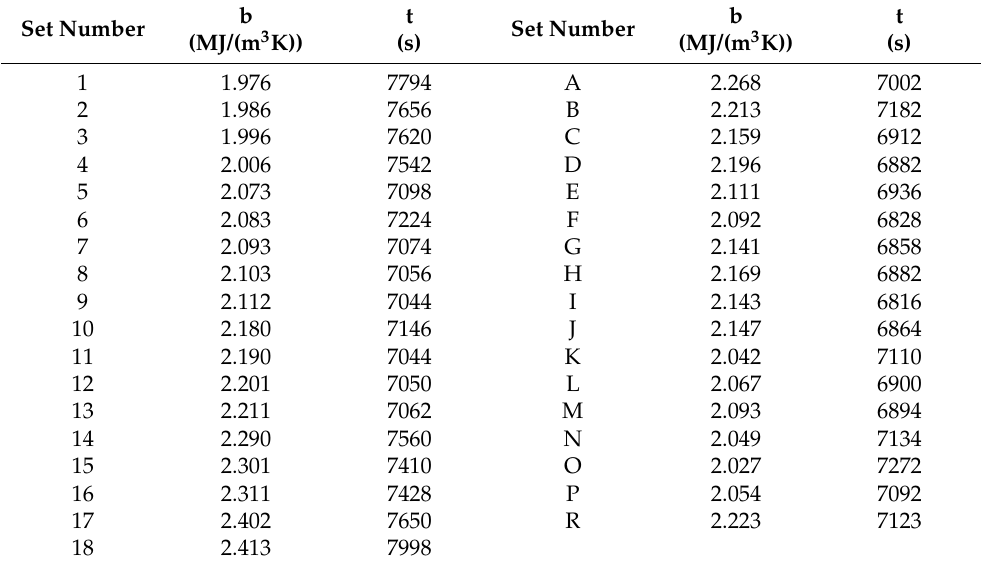
Table 5. Volumetric heat capacity b, and eutectic formation time, of three-component system: Gresflux spodumene, Albitte 5, Norfloat Spar, according to the compositions shown in Figure